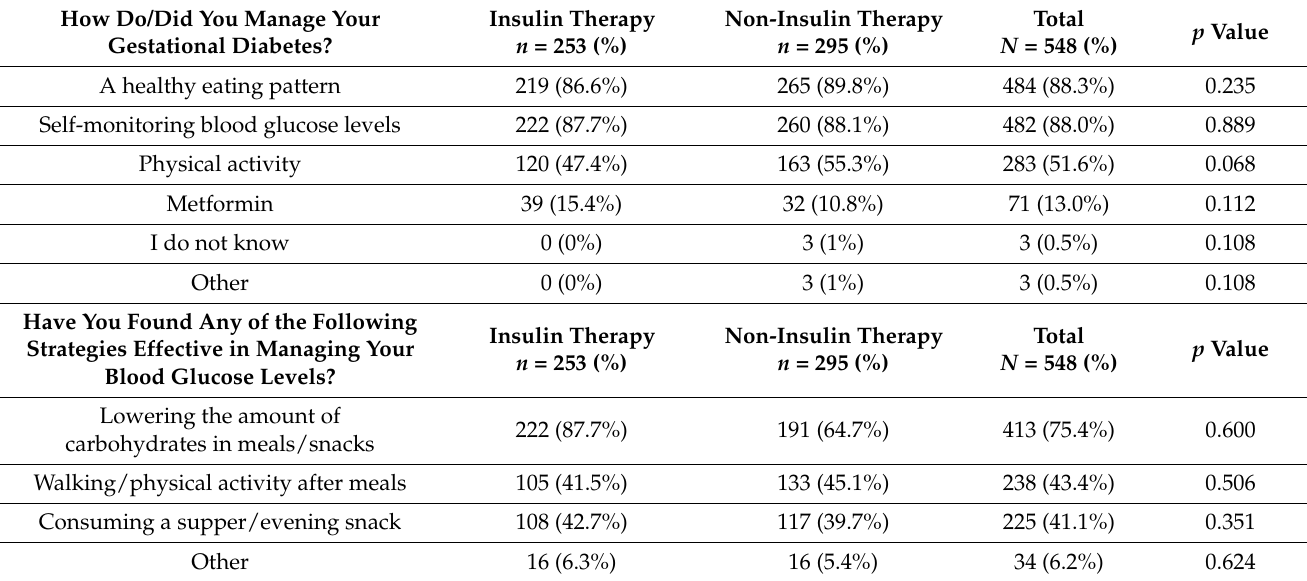
Table 1. Strategies for managing GDM.